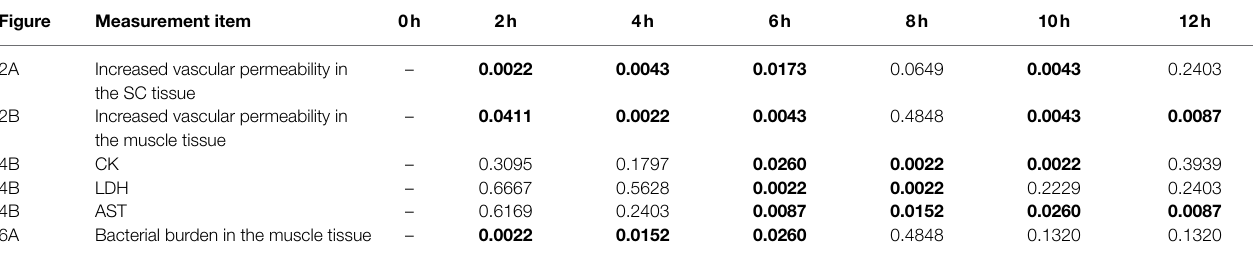
TABLE 1 | Summary of p values from Mann–Whitney U test. Figure Measurement